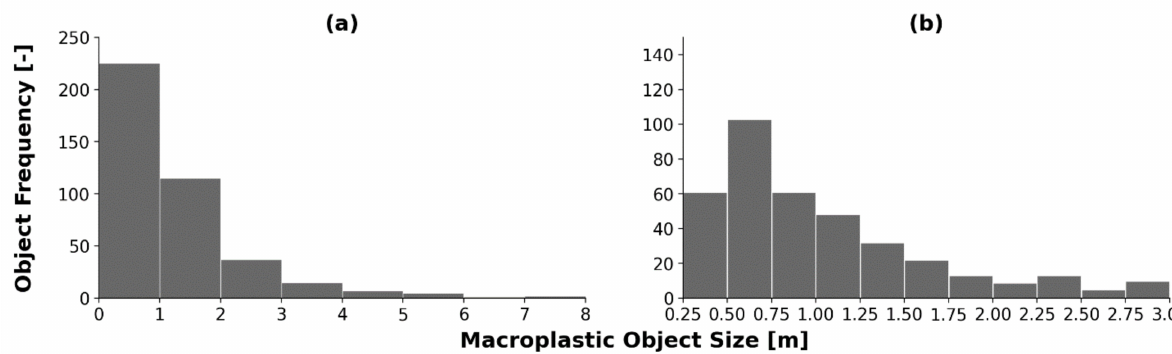
Figure 9. ( a ) Size distribution of the detected macroplastic objects (major axis of the bounding box), indicating that most observed objects are smaller than 1 m. ( b ) A finer size distribution between 0 m and 3 m reveals no significant object detections below 0.25 m and a peak between 0.50 m and 0.75